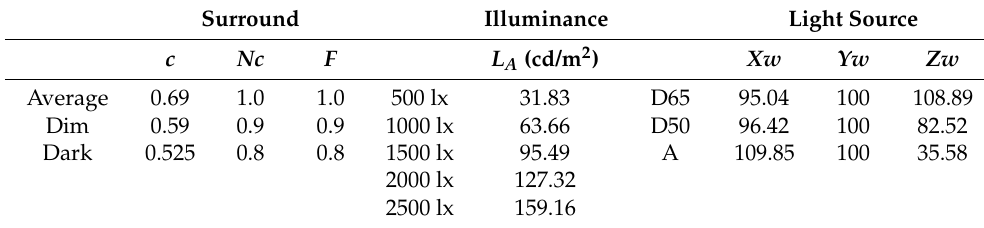
Table 1. Input parameters of CIECAM16